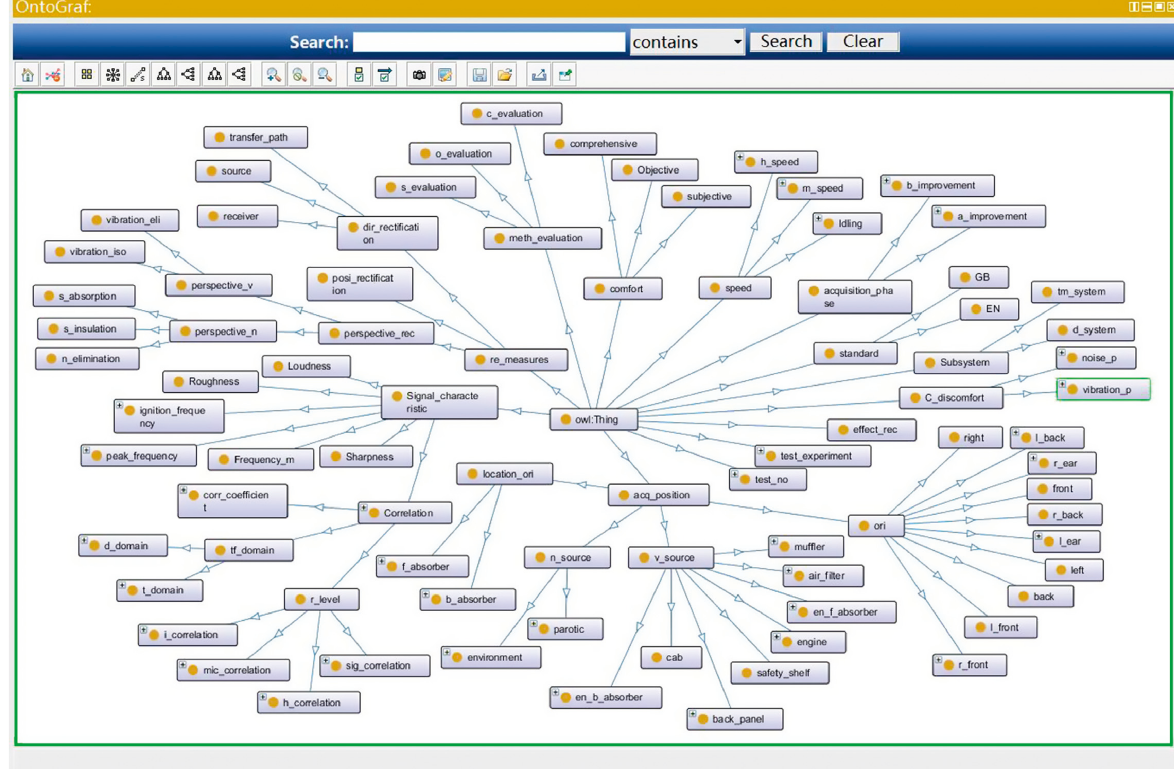
Figure 5: Ontology knowledge